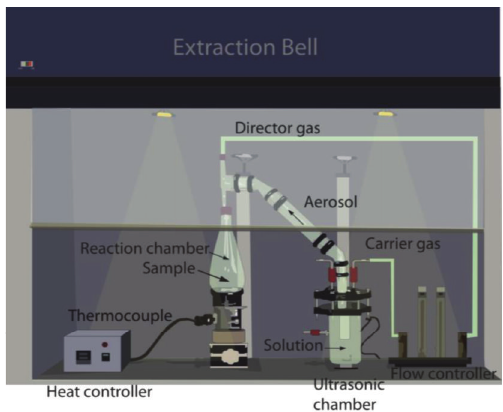
Figure 1: Schematic diagram of the experimental setup used for the deposition of the ZnO:Zr:F thin solid films by the